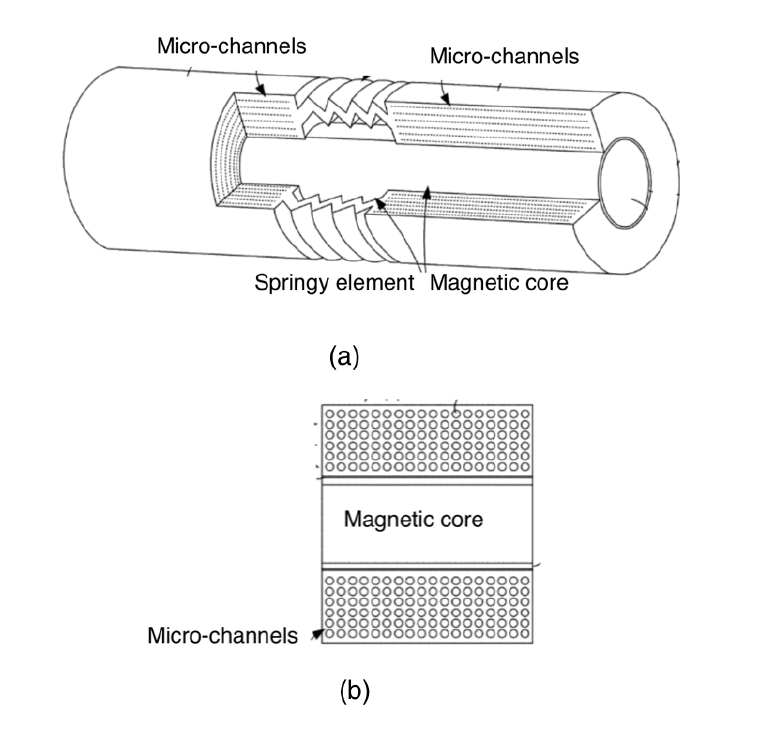
Figure 1. Design concept of an Electromagnetic Soft Actuator (ESA): ( a ) Schematic and ( b ) cross-section